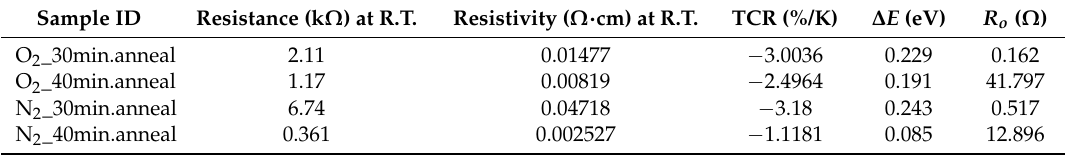
Table 1. Summary of measured and extracted electrical properties for V/V 2 O 5 thin film resistive